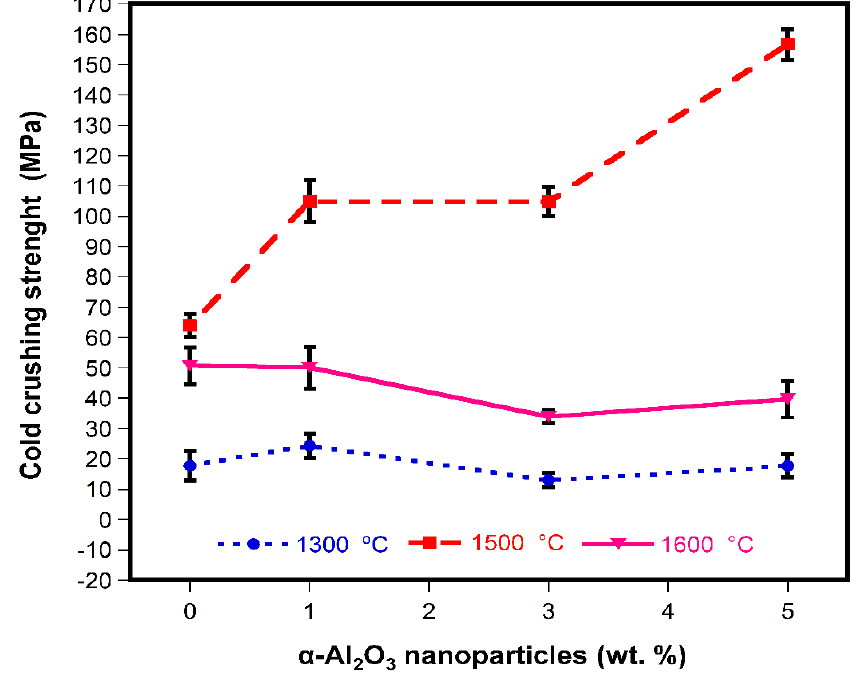
Figure 9. Cold crushing strength at different α -Al 2 O 3 nanoparticles content. Table 5. Physical and mechanical properties of MgO-based refractories from laboratory studies and commercial refractories.